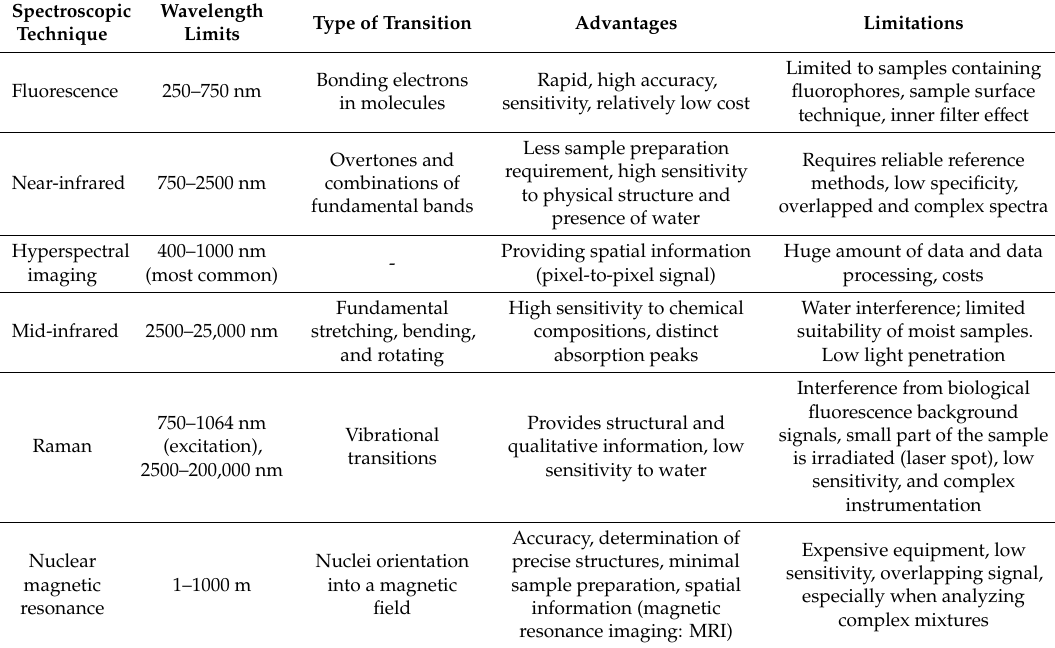
Table 3. The pros and cons and other characteristics of the main spectroscopic techniques. The table is adopted from